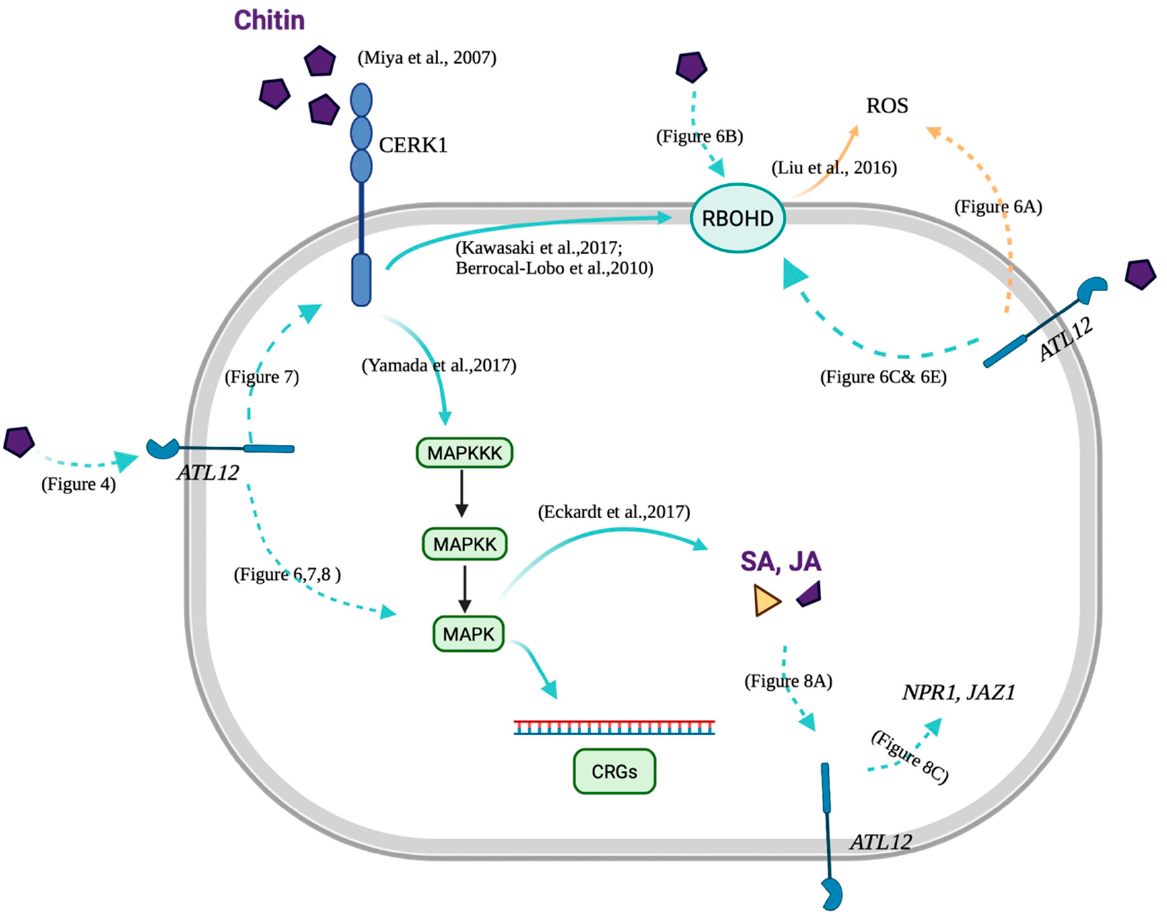
Figure 9. A possible model of ATL12 function in the hormone, NADPH oxidase-mediated and the chitin-mediated defense. ATL12 is at the downstream of chitin-mediated signaling pathway, through the MAP kinase 3 (MAPK3) cascade. Besides, ATL12 is related to ROS generation and may act at the upstream of ATRBOHD/F-related signaling transduction pathway. Moreover, ATL12 may be involved in the SA-, and JA-mediated signaling pathway [42]. The figure with created with BioRender.com with license agreement number DV2337X56K.